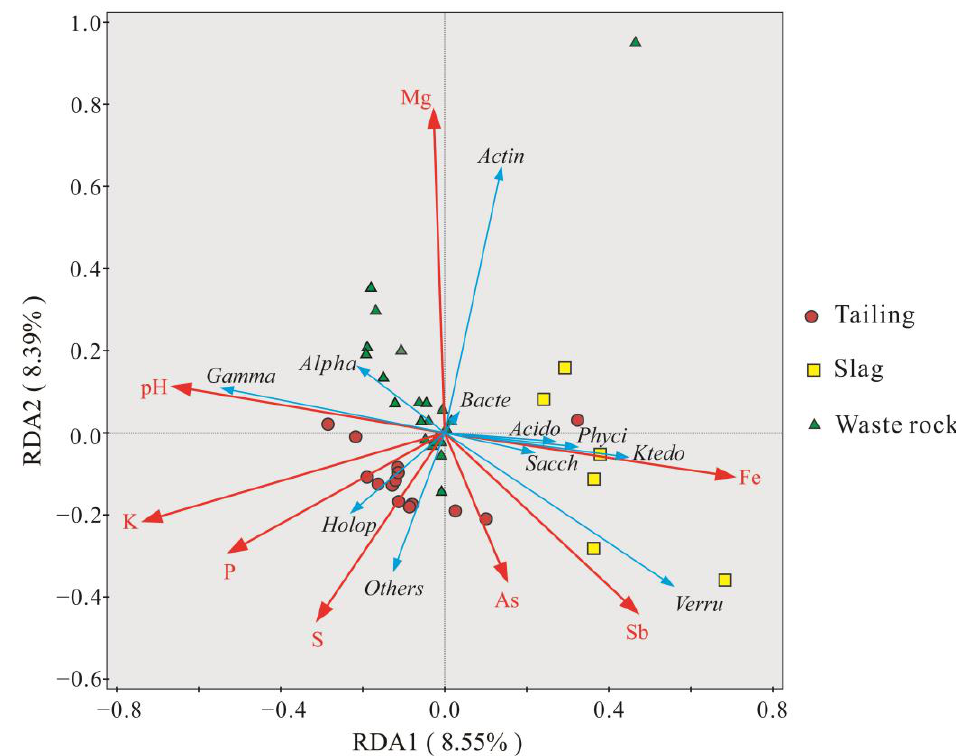
Figure 8. Redundancy analysis of the composition and geochemical parameters of the rhizosphere microbial community (Class level) of three mine waste plants. (Meaning of abbreviations in the figure: Bacte : Bacteroidia , Gamma : Gammaproteobacteria , Alpha : Alphaproteobacteria , Actin : Actinobacteria , Verru : Verrucomicrobiae , Ktedo : Ktedonobacteria , Acido : Acidobacteriae , Sacch : Saccharimonadia , Phyci : Phycisphaerae , Holop : Holophagae ).